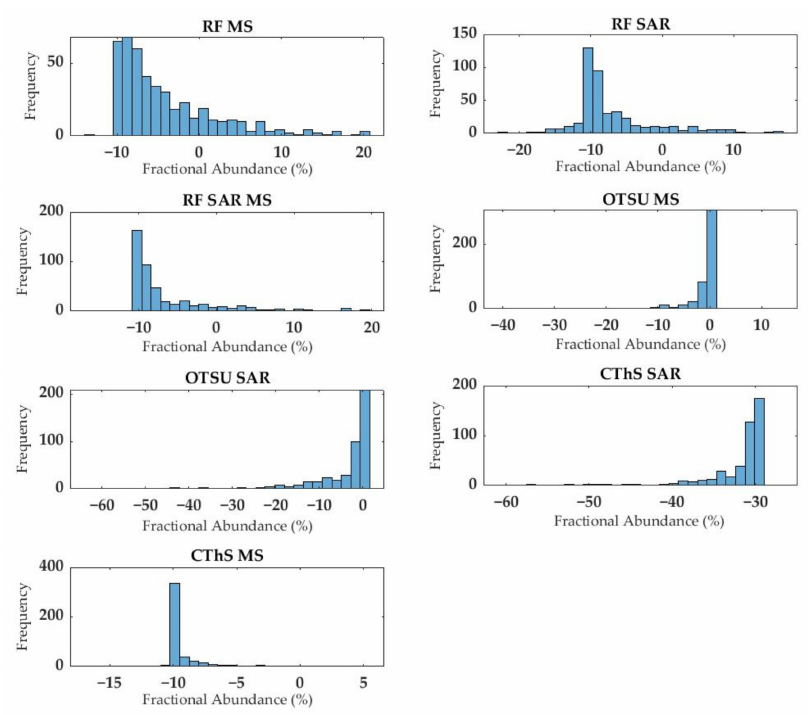
Figure 12. Deviation from the median value of the fractional abundance of water (event 2017) calculated over the nodes of a regular 500 m grid.